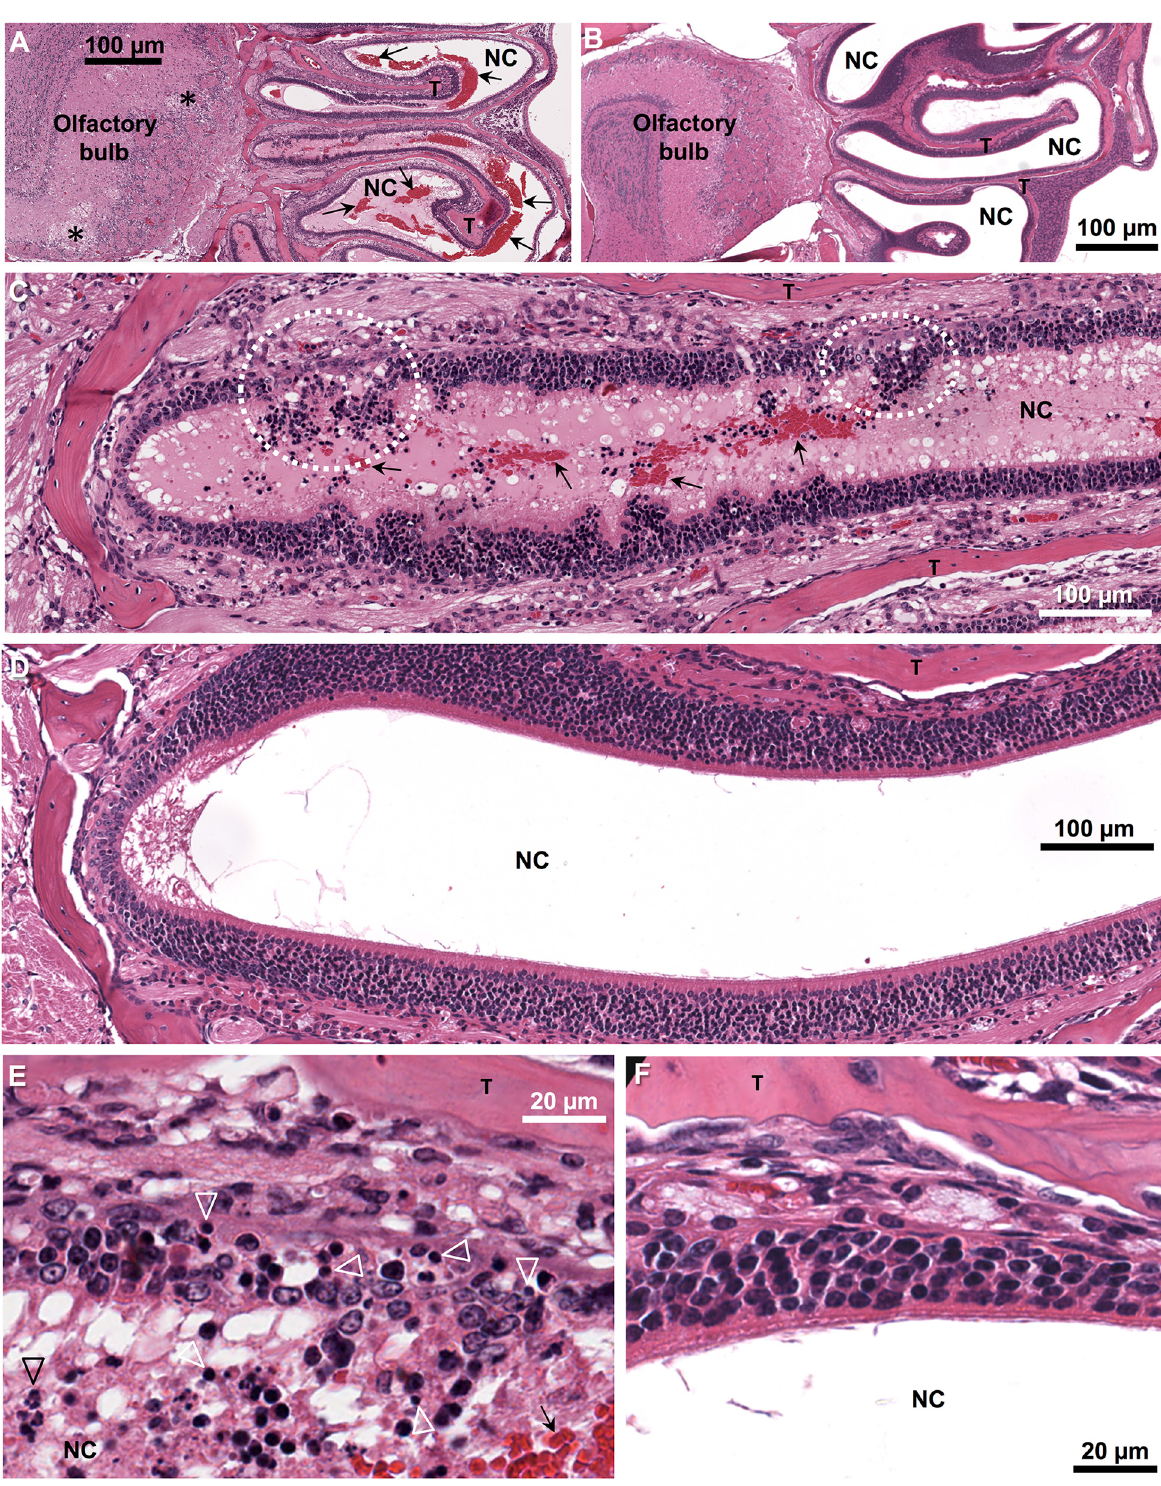
Fig 1. Hemorrhagic lesions in the olfactory epithelium of CHIKV infected IRF3/7 -/- mice. (A, C, E) H&E of the head of IRF3/7 -/- mouse day 5 post CHIKV infection and (B, D, F) H&E of the head of a control uninfected IRF3/7 -/- mouse; T — turbinate bones, arrows — red blood cells, NC — nasal cavity. (A) Low magnification image showing extensive red blood cells and mucous exudates (pink staining material) in the nasal cavities. ( * — large foci of vacuolization in the olfactory bulb). (B) The same region and magnification as in A for an uninfected mouse. (C) Medium magnification image showing breaches in the